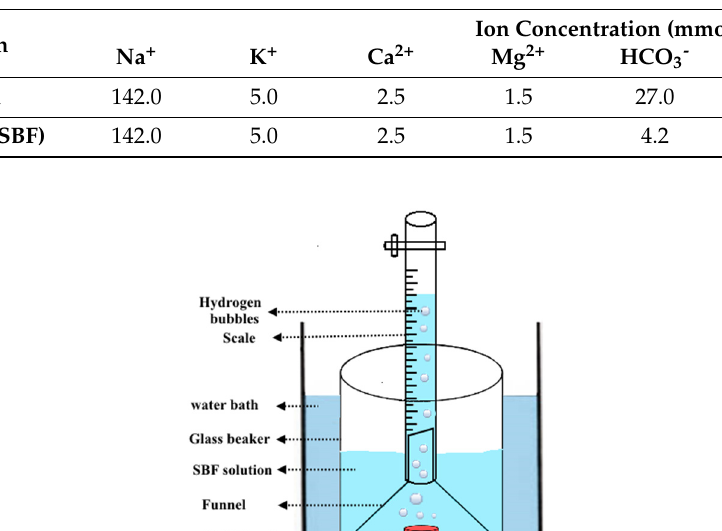
Table 2. Chemical composition of the Kokubo simulated body fluid (SBF) compared to the human blood plasma.